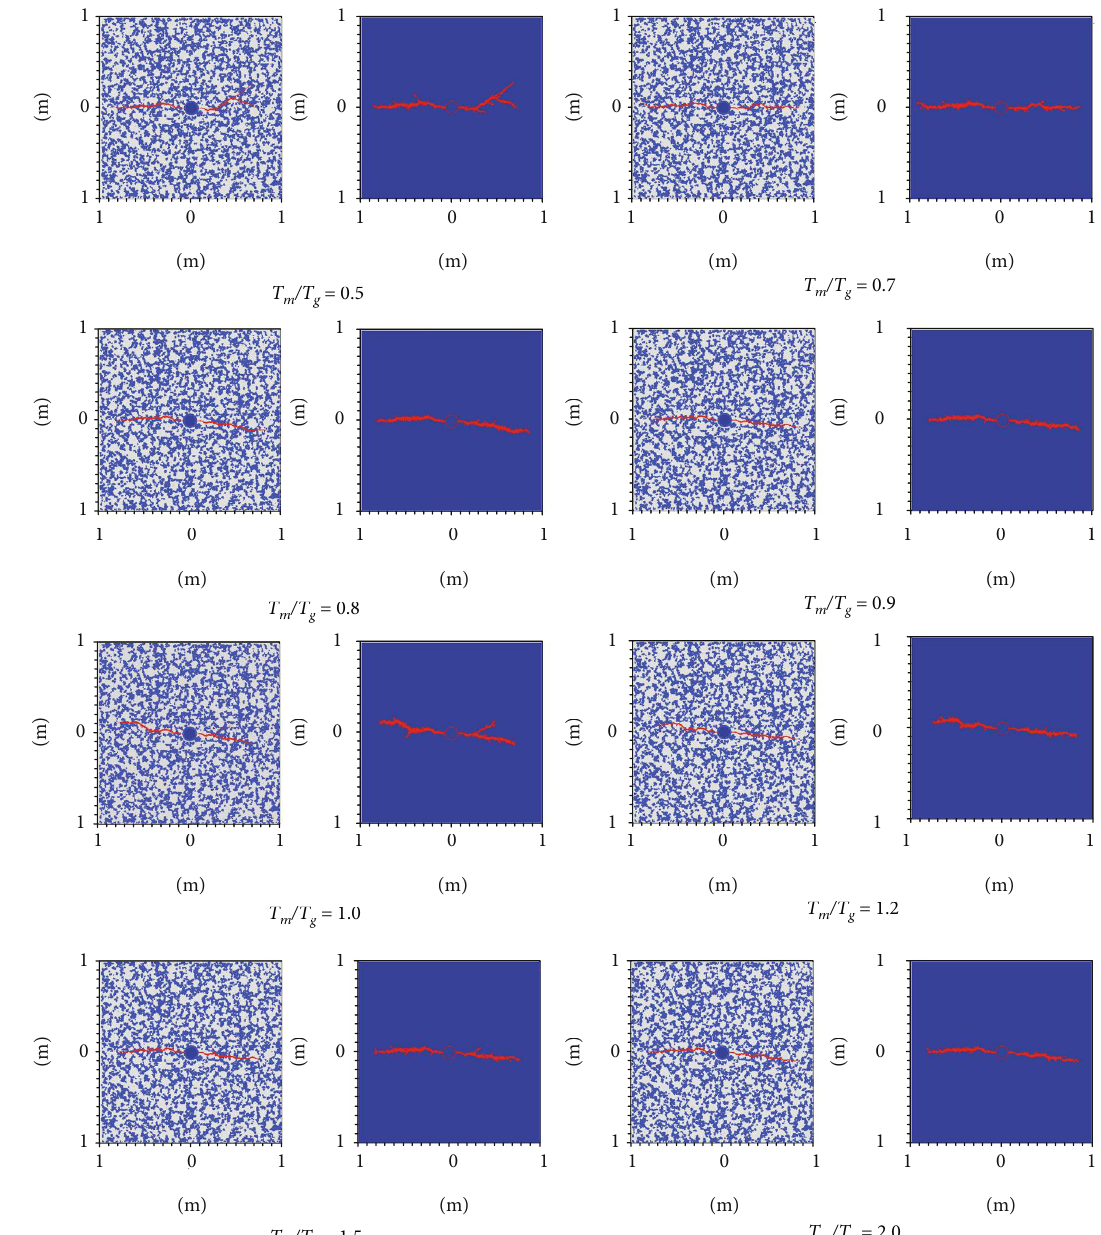
Figure 11: HF propagation morphology under di ff erent ratios of the tensile strength of the matrix to